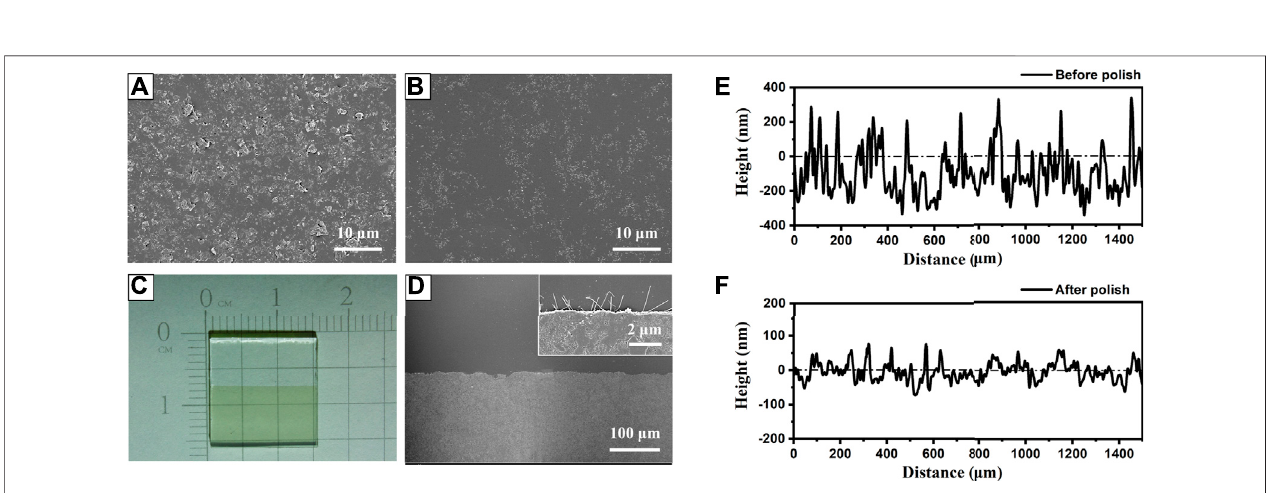
Frontiers in Chemistry |